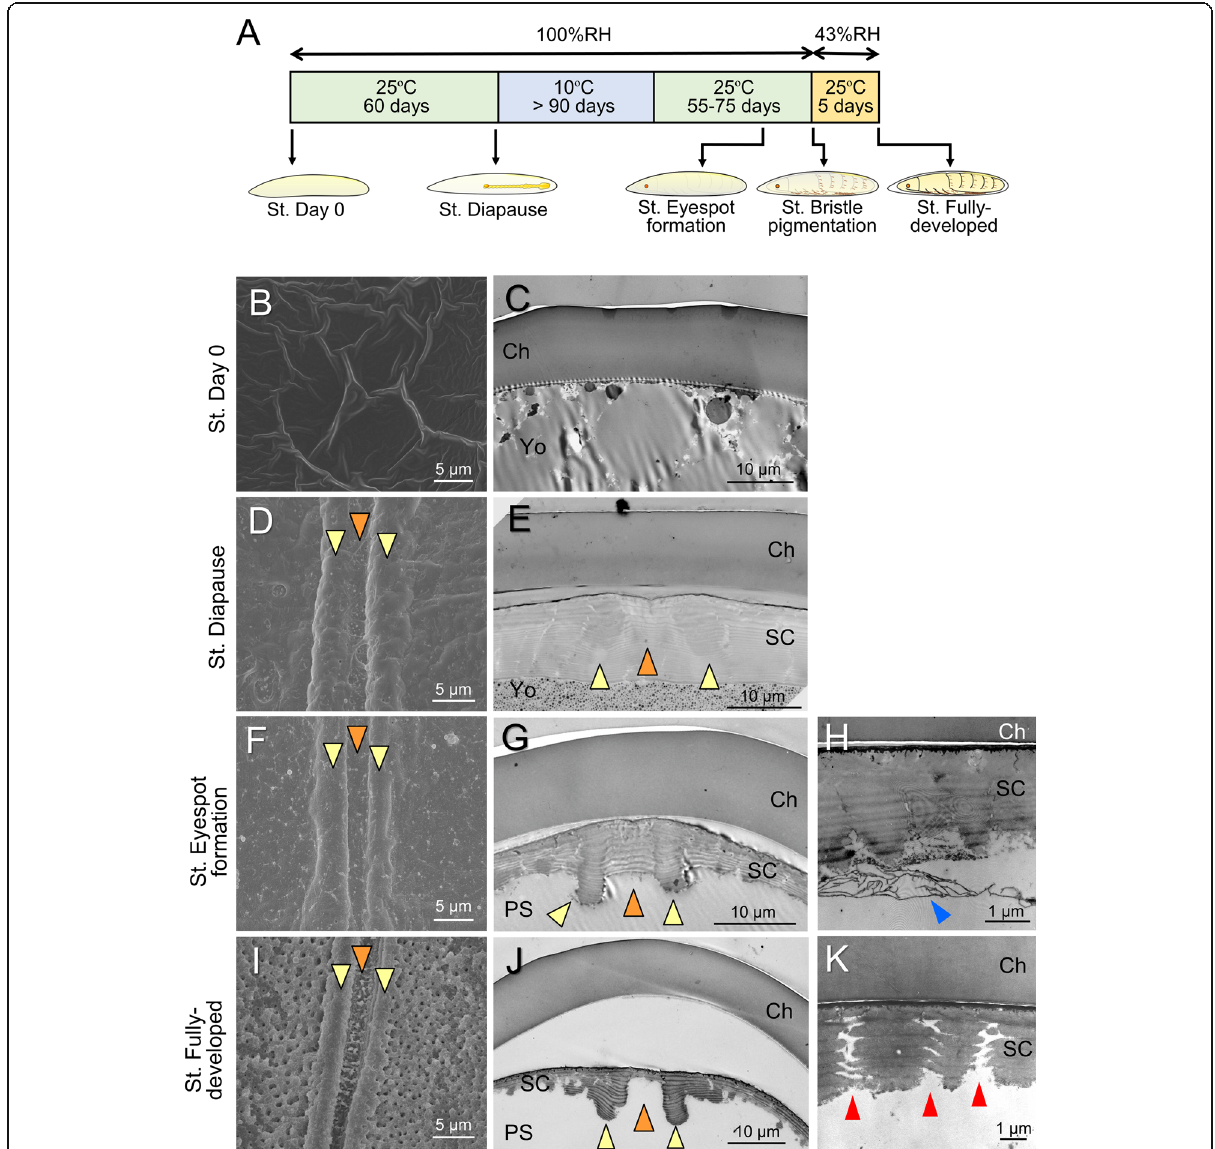
Fig. 4 The developmental process of hatching-line formation in the serosal cuticle. a Time course of embryonic development and sampling points. b, d, f, i SEM images of the inner surface around the dorsal hatching line at each developmental stage. c, e, g, j Transverse TEM images of the area around the dorsal hatching line. Orange and yellow arrowheads indicate furrow and ridge positions, respectively. h A magnified image of the degrading serosal cuticle at the stage of eyespot formation (blue arrowhead). k A magnified image of pores that appeared in fully developed eggs (red arrowheads). Abbreviations: Ch, chorion; SC, serosal cuticle; PS, periembryonic space; Yo,